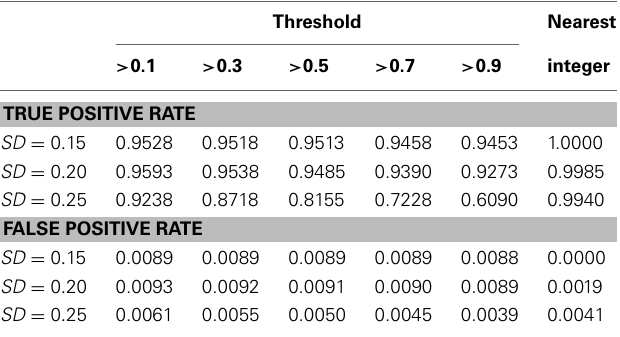
Table 4 | True positive rate and false positive rate of detecting mutation family under various standard deviation of PCR-based typing by the Bayesian hierarchical model and the method of nearest integer.